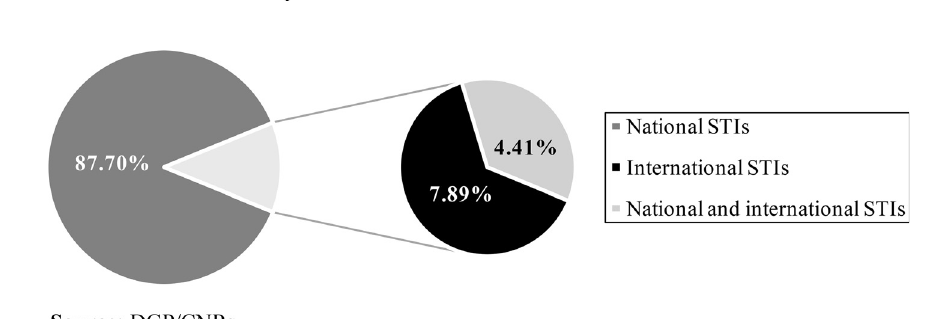
Figure 3. Categories of